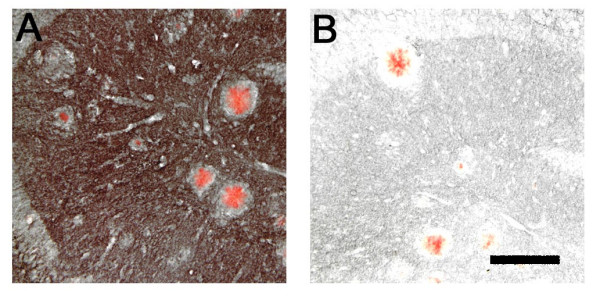
Verification of Na+/K+ ATPase αIII antibody specificity by immunohistochemistry following pre-incubation with purified protein and Western blotting. Horizontal sections were immunostained for Na+/K+ ATPase αIII with (Panel B) and without (Panel A) pre-incubation with 70 μunits of purified enzyme followed by Congo red staining. The pre-incubation significantly decreased staining, confirming antibody specificity. Scale bar = 50 μm.